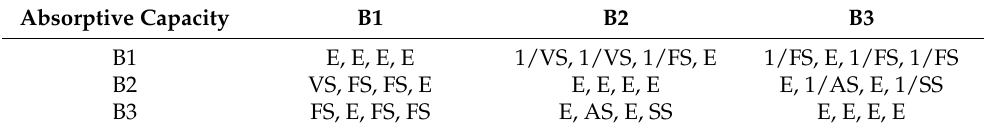
Table 4. Comparison matrix of the importance of secondary indicators under absorptive capacity.